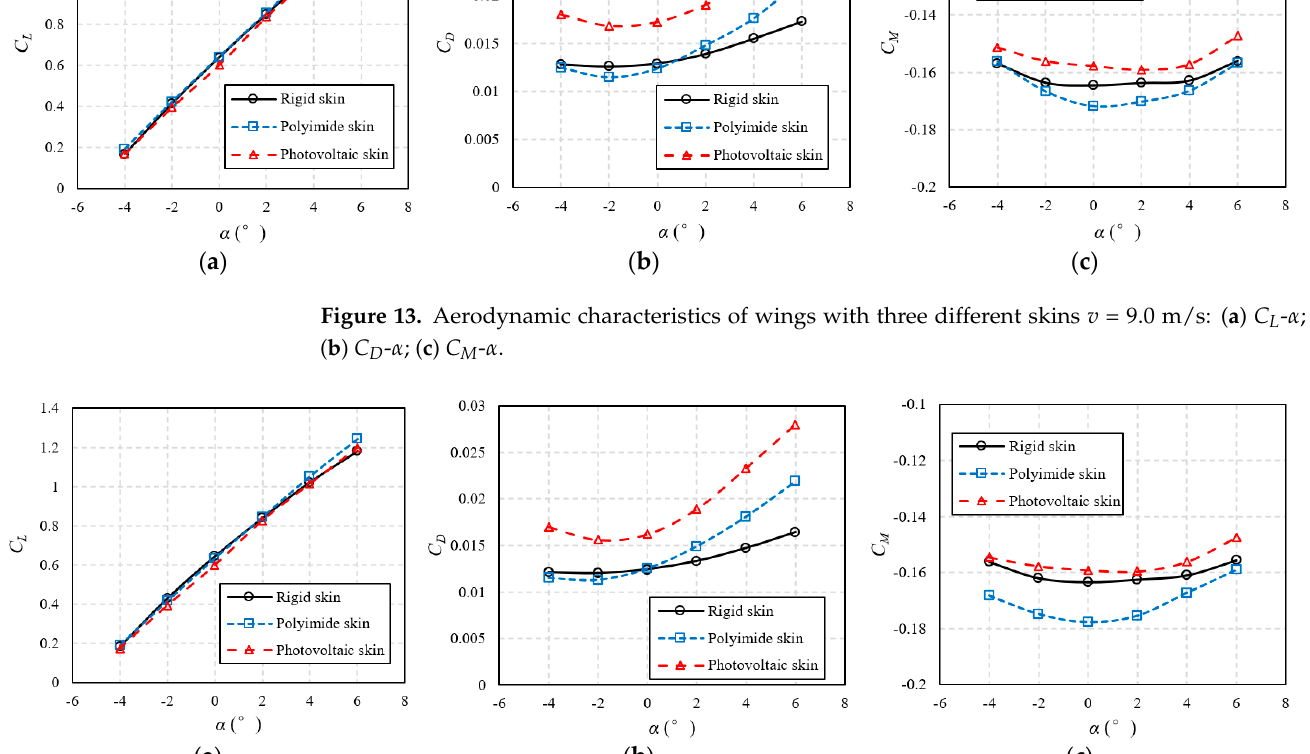
Figure 14. Aerodynamic characteristics of wings with three different skins v = 11.0 m/s: ( a ) C L - α ; ( b ) C D - α ; ( c ) C M - α .